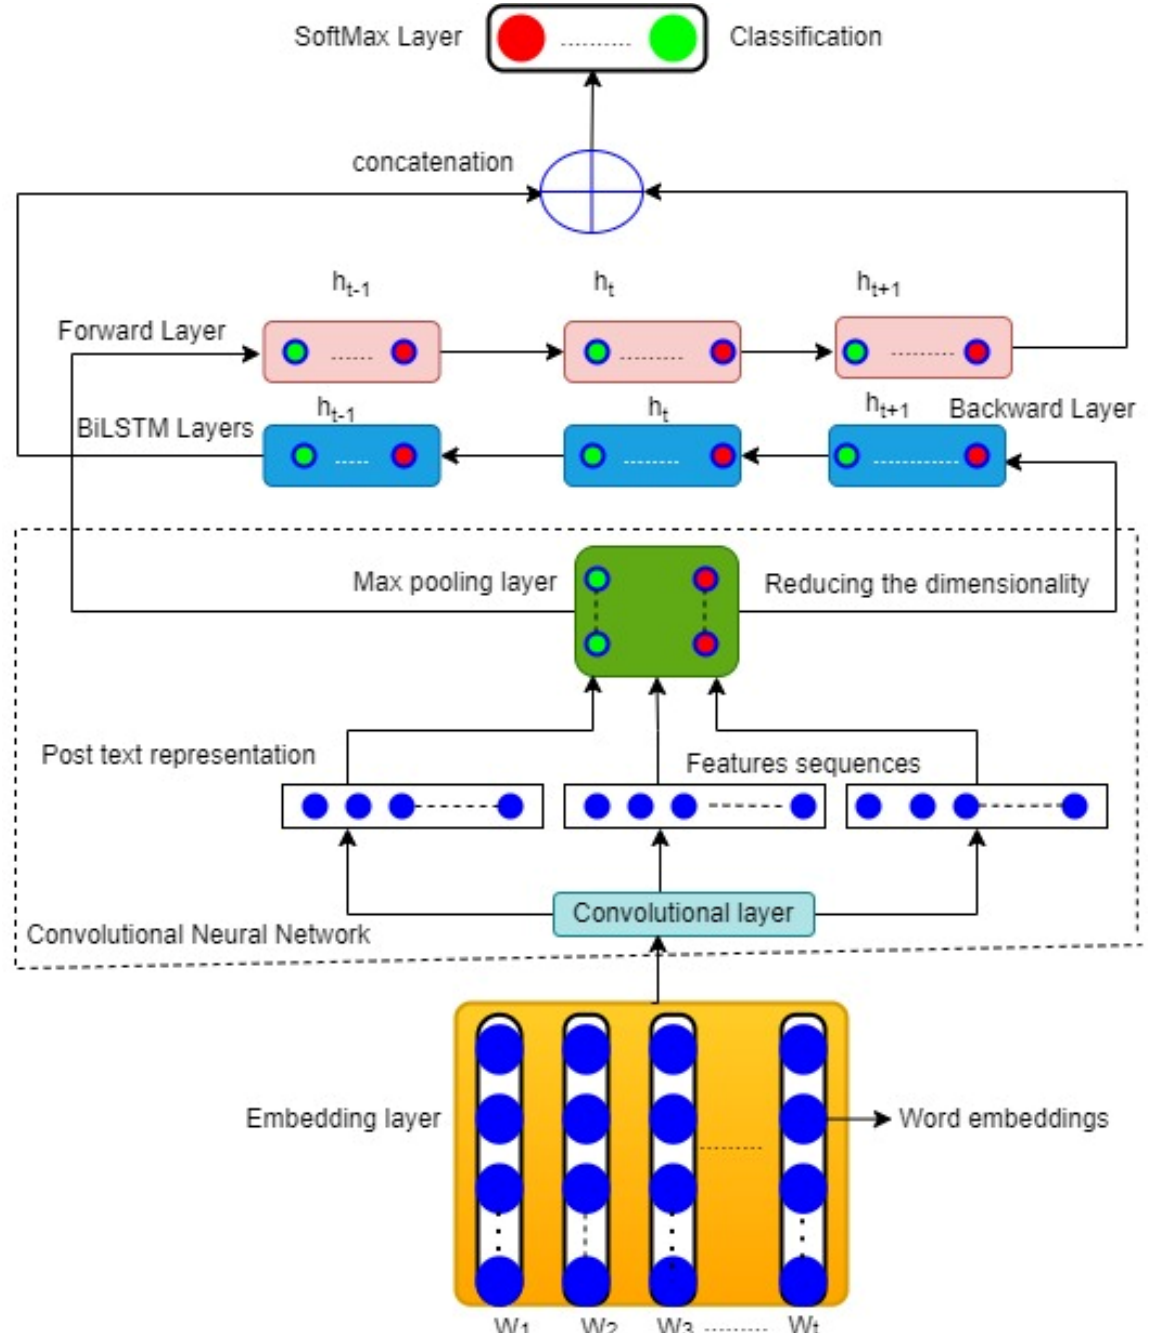
Figure 4. Structure of the CNN-BiLSTM model for cyberbullying detection.